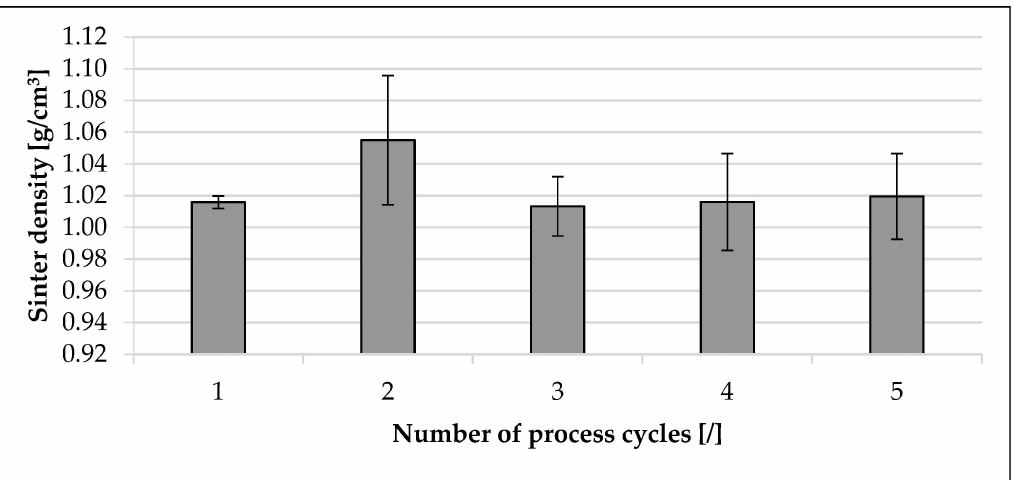
Figure 14. Influence of cyclic reuse on sinter density. Five process cycles were considered. The refresh rate was 30 wt%.